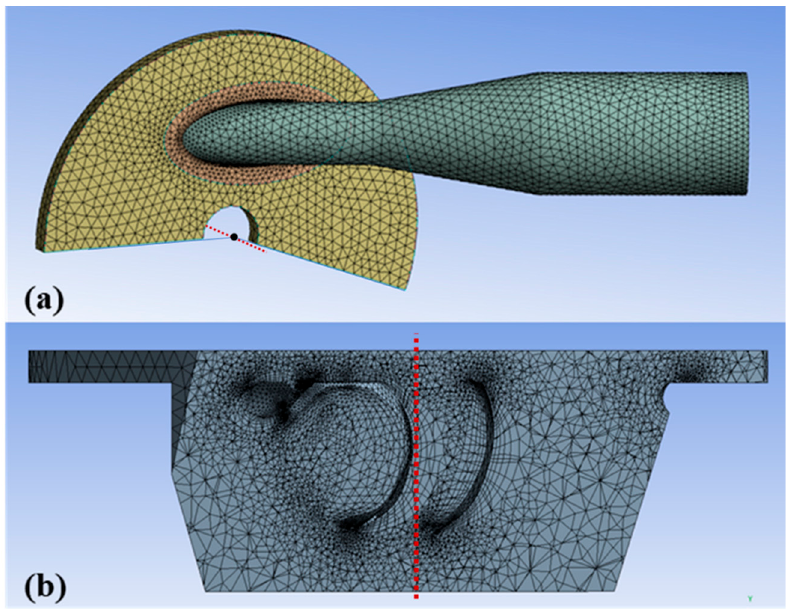
Figure 6. ( a ) Stationary domain and ( b ) rotating domain. For both domains, a red, dashed line indicates the rotational axis of the turbine.